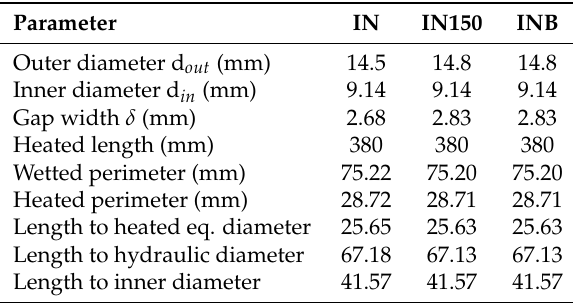
Figure 4. ( a ) design of the first measurement probe; ( b ) photo of the first probe; ( c ) design of the second measurement probe; ( d ) photo of the second probe ( e ) design of the third measurement probe; ( f ) photo of the third probe. Table 2. The details of test annulus